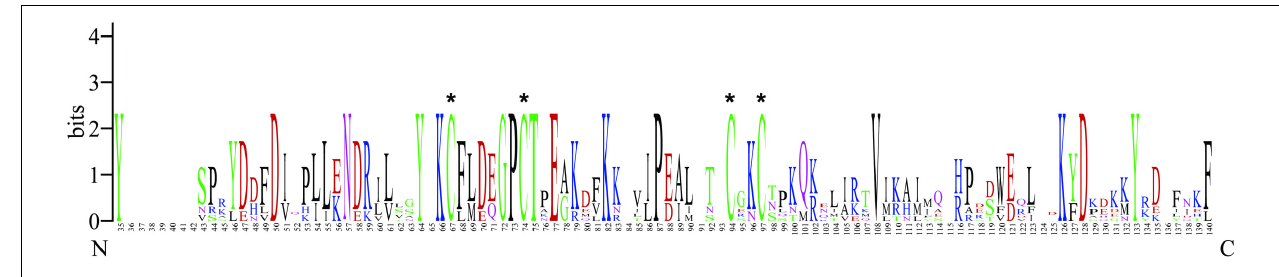
FIGURE 1 | WebLogo alignment of BtabCSP11 with six other hemipteran CSPs. “*”denotes highly conserved cysteines. N, N-terminus, C,